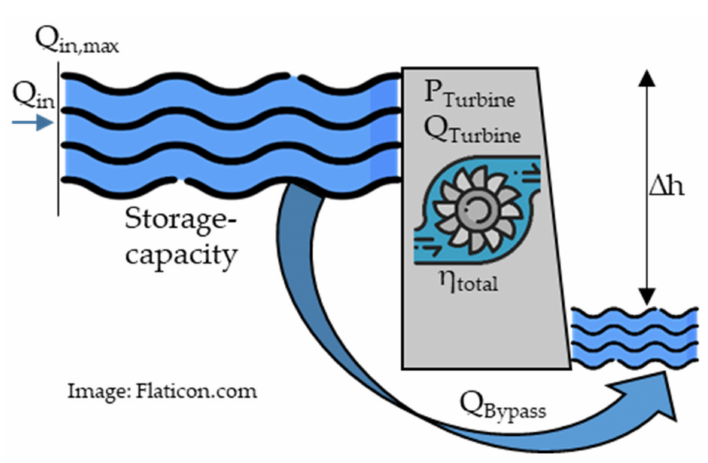
Figure 9. Hydro run-off and storage power plant model. Each run-off and storage power station with a generation capacity greater than 10 MW is implemented into Austria’s MES model in its corresponding SSD. Power station data are sourced from [67–79]. The temporally resolved generation is determined using run-off water measurements [80]. If the measurement point is different to the power station’s location, interpolation is conducted between two measurement points. For hydropower stations with less than 10 MW, a different approach had to be used. Kleinwasserkraft Österreich [81] provides power and annual generation data for small-scale hydropower stations. These data are used together with hydropower potentials from [8] to determine small-scale hydropower in each SSD. Since no sufficient run-off measurements are available for small rivers, a standardized load profile based on measured data from small rivers (refer to Appendix B for measurement points) [80] is created, presented in Figure 10. A polynomial trend curve is used to smoothen the